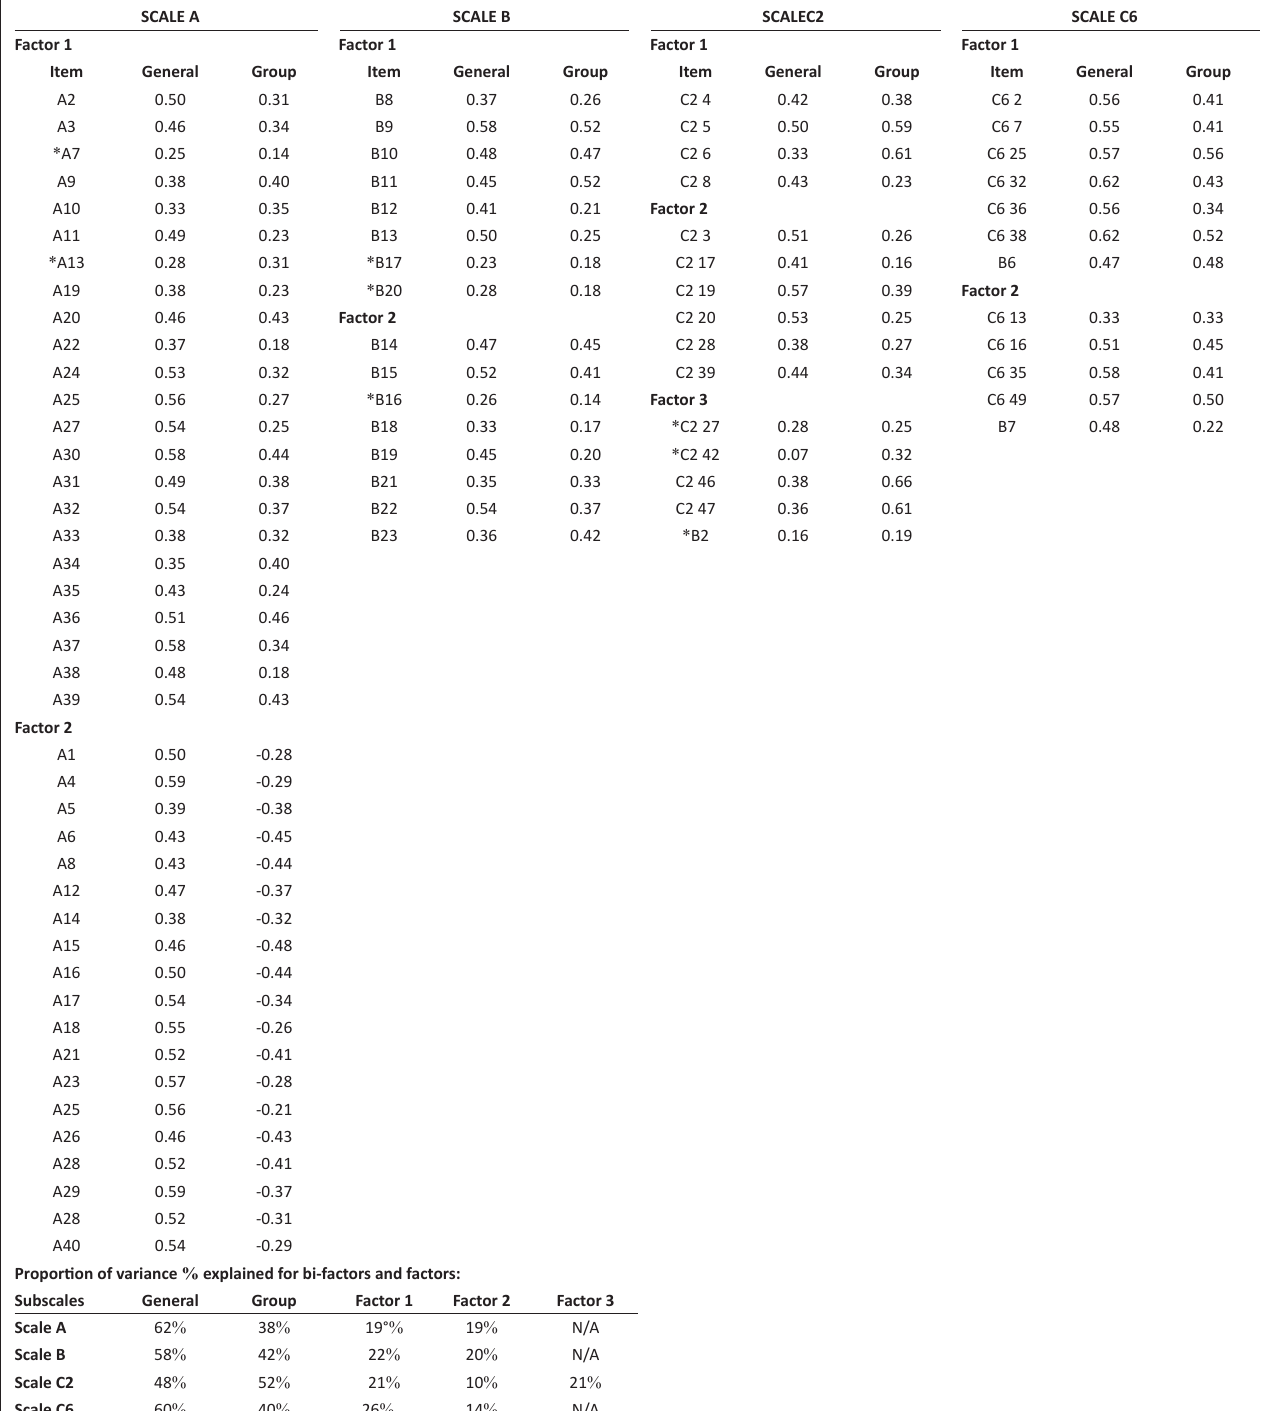
FIGURE 4: Detailed findings from bi-factor analysis using Schmid–Leiman analysis.